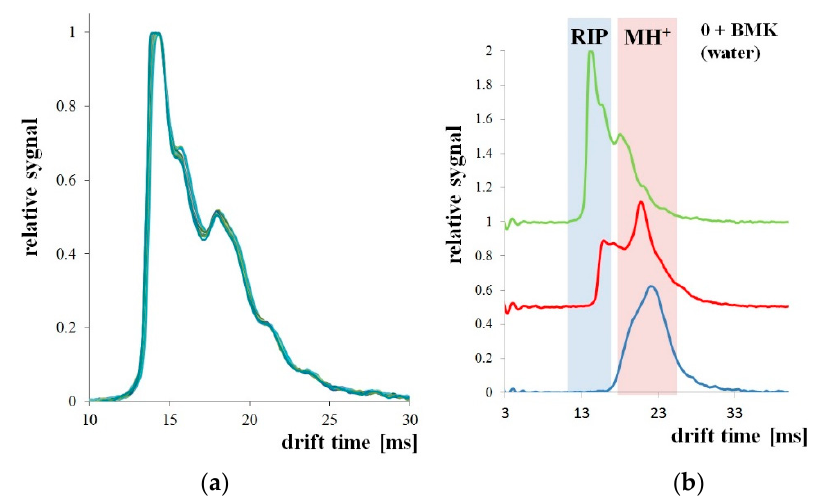
Figure 7. Microporous PP tubing immersed in BMK solution: ( a ) for 30 min; ( b ) for 3 h (1 h).